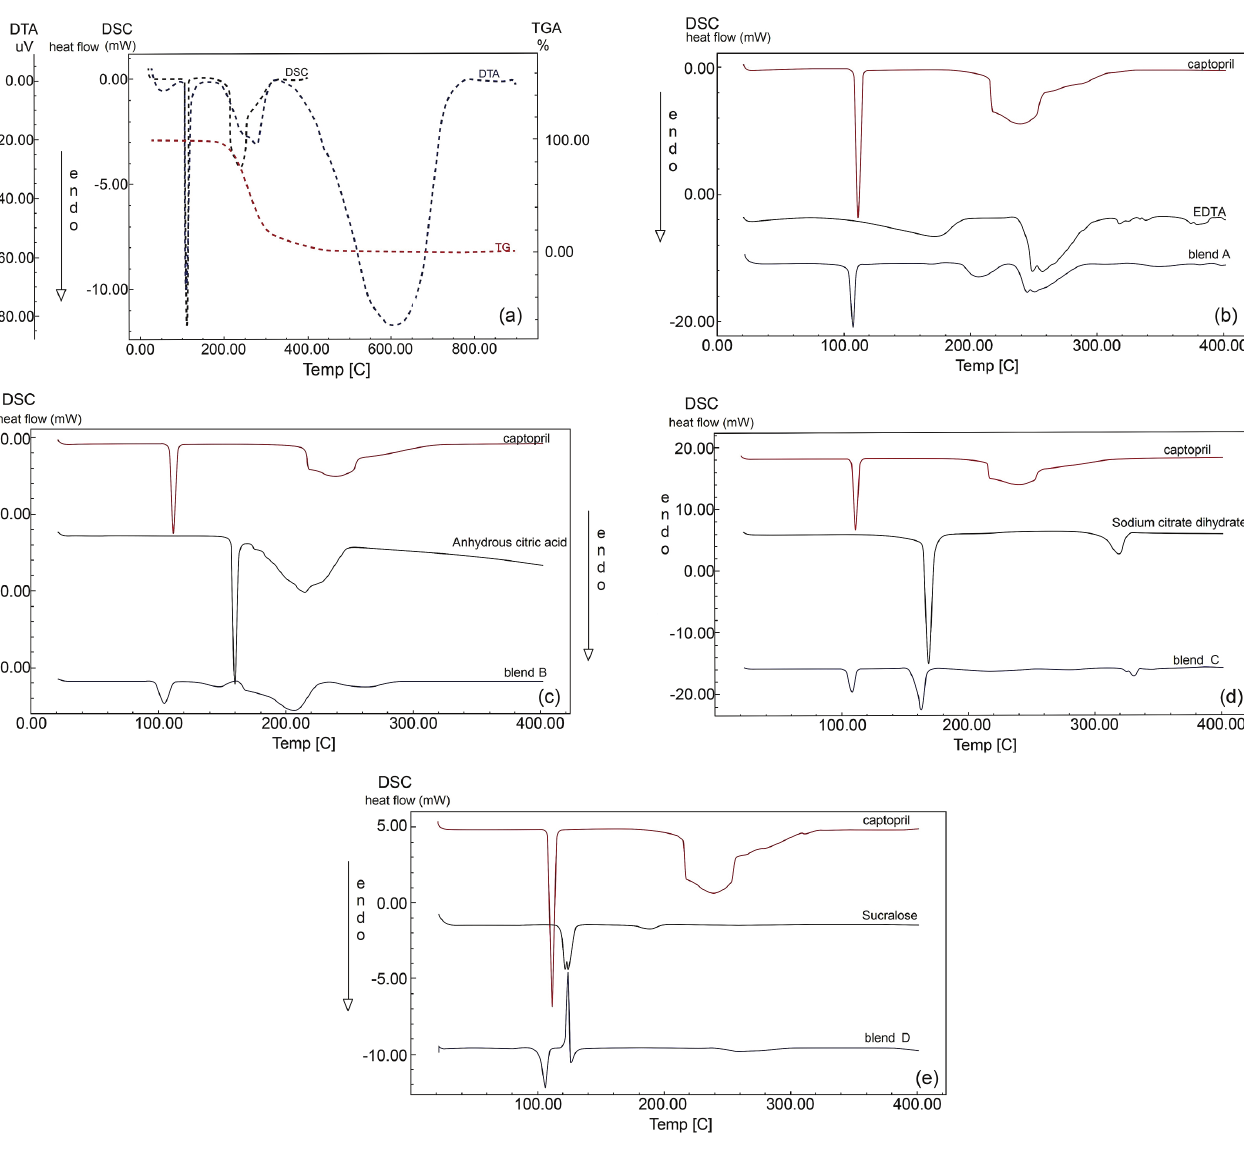
FIGURE 1 – DSC, TG DTA and captopril curves ( a ) and DSC curves of excipients and their respective binary mixtures with the drug ( b : EDTA and mixture A; c : citric acid and mixture B; d : dihydrate sodium citrate and mixture C; and e : sucralose and mixture D). pH value (Fc, Ff, Fi and Fl) are less stable, showing degradation of 1.7 to 3.6 times faster than captopril